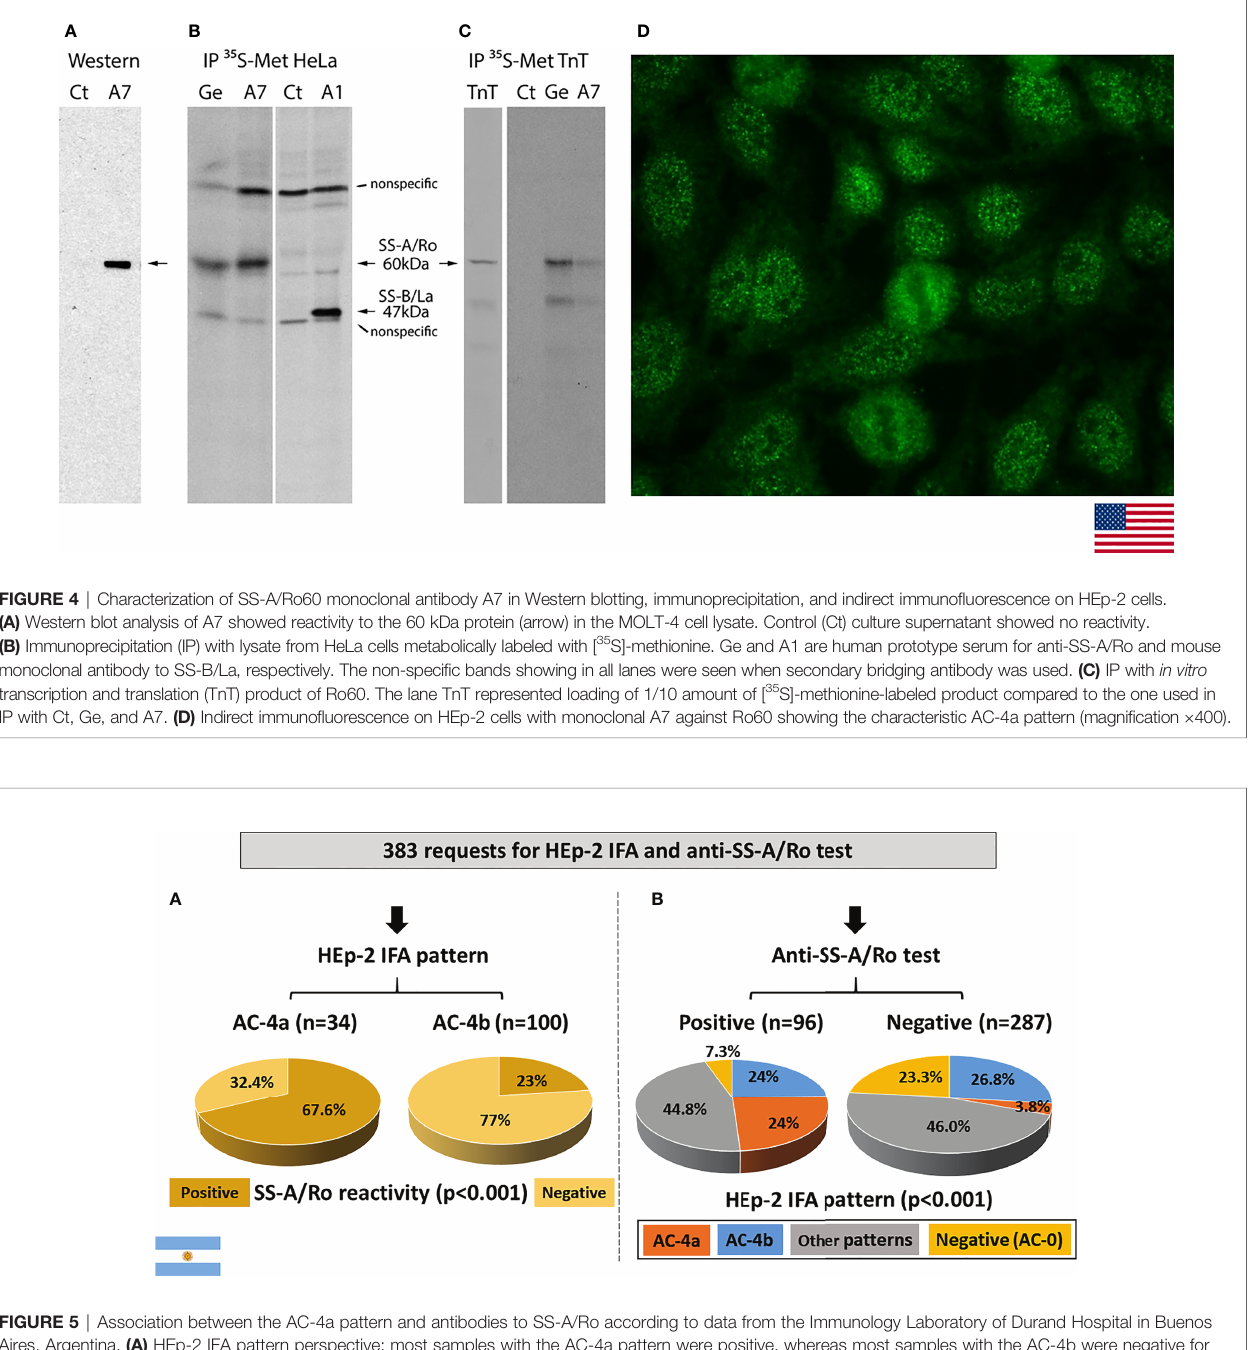
FIGURE 5 | Association between the AC-4a pattern and antibodies to SS-A/Ro according to data from the Immunology Laboratory of Durand Hospital in Buenos Aires, Argentina. (A) HEp-2 IFA pattern perspective: most samples with the AC-4a pattern were positive, whereas most samples with the AC-4b were negative for anti-SS-A/Ro. (B) Anti-SS-/Ro antibody perspective: the AC-4a pattern was prevalent in samples positive for anti-SS-A/Ro60 and rare in negative samples. In contrast, the AC-4b pattern showed similar frequency in samples positive and negative for